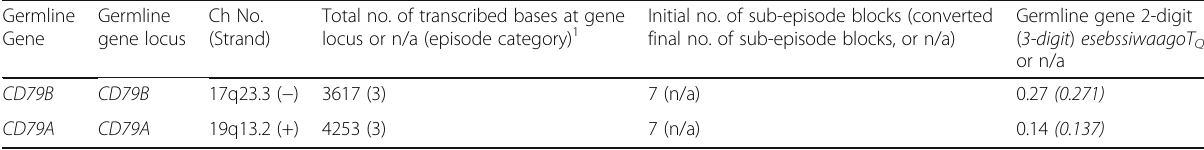
Germline gene 2-digit ( 3-digit ) esebssiwaagoT Q ,